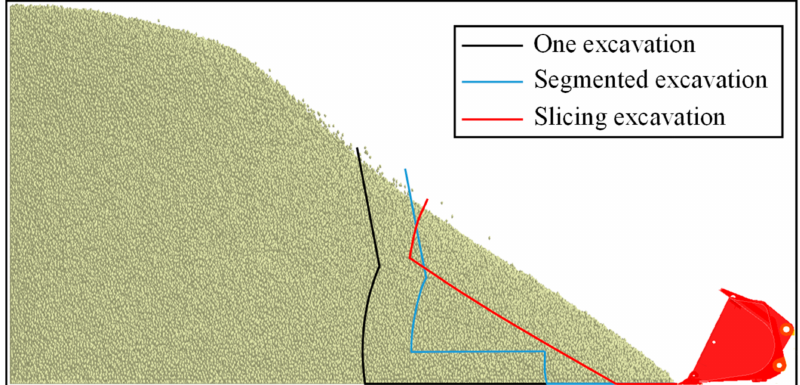
Figure 5. Schematic diagram of the shoveling